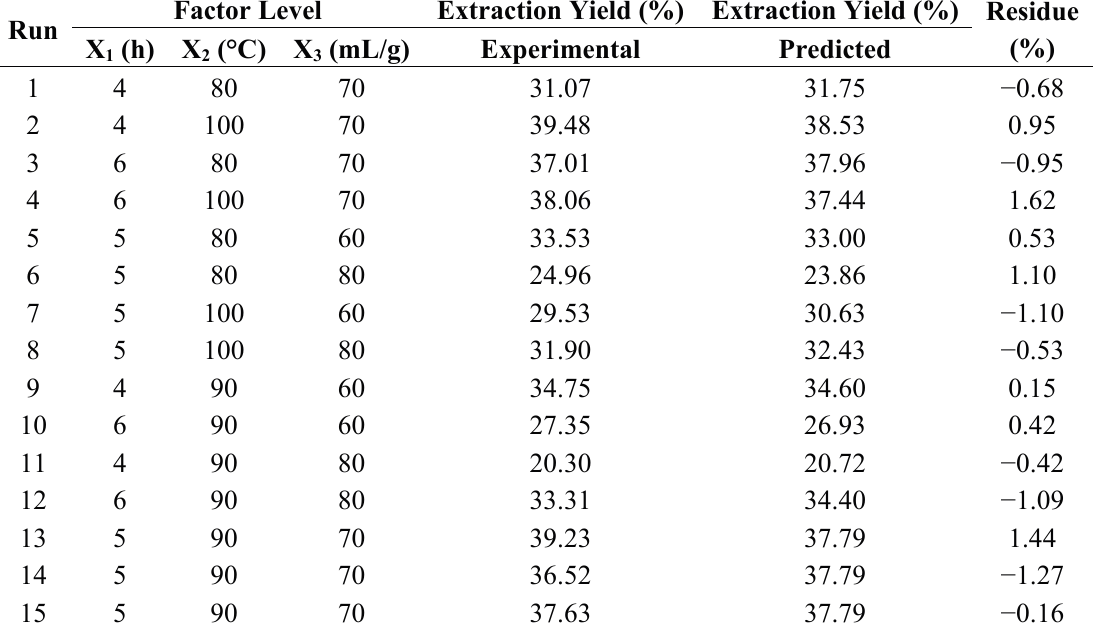
Table 2. Design and results of Box-Behnken design used to examine extraction yield of G. livida (Harv.) Yamada (GL)